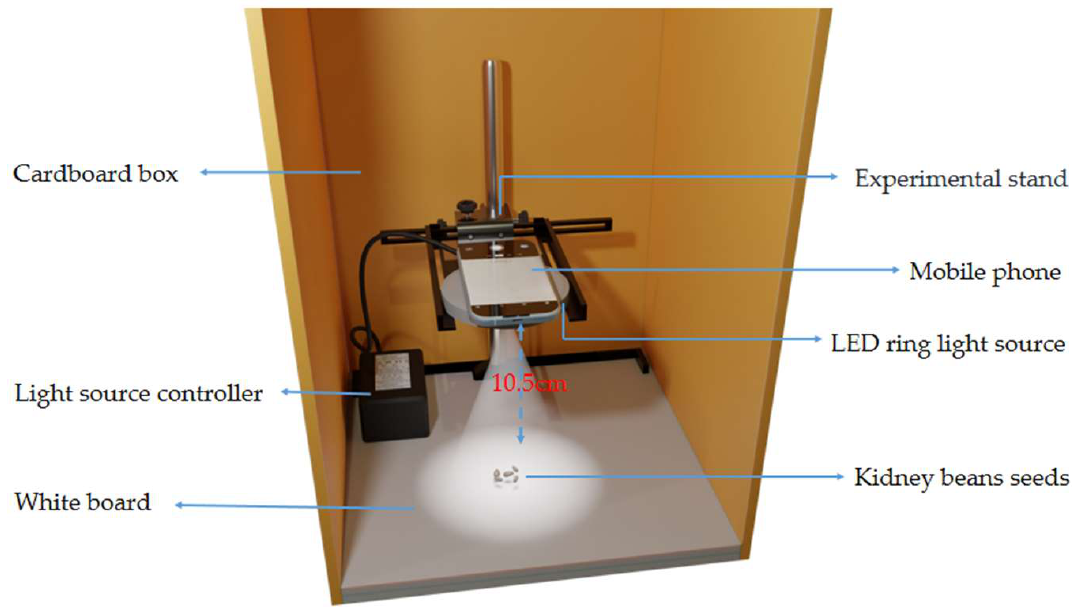
Figure 1. The diagram of the image acquisition system.